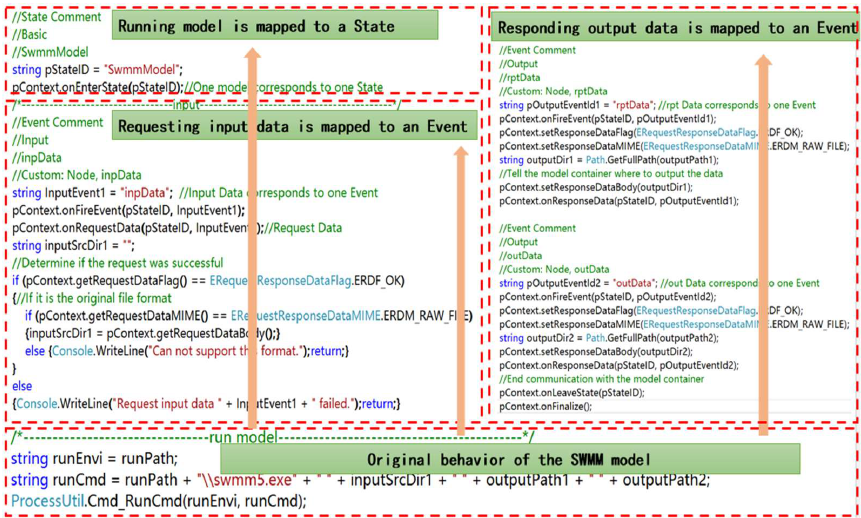
Figure 5. Encapsulation code for the SWMM execution interface.